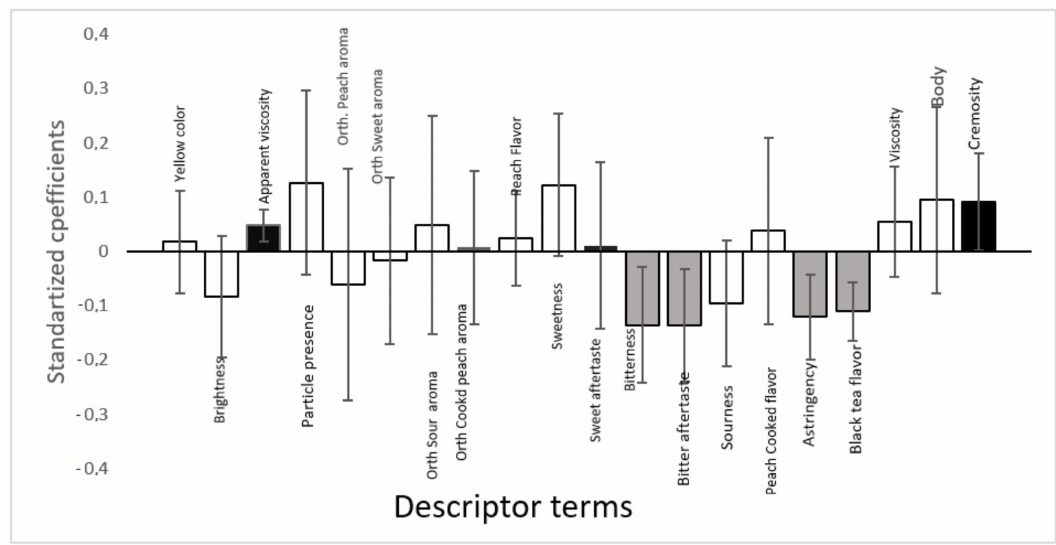
Figure 3. Partial least squares standardized coefficients of peach juice with sweeteners (black, descriptor terms that contribute positively to consumer acceptance; white, descriptive terms that did not significantly contribute to consumer acceptance; grey, descriptor terms that contribute negatively to consumer acceptance) 95% confidence